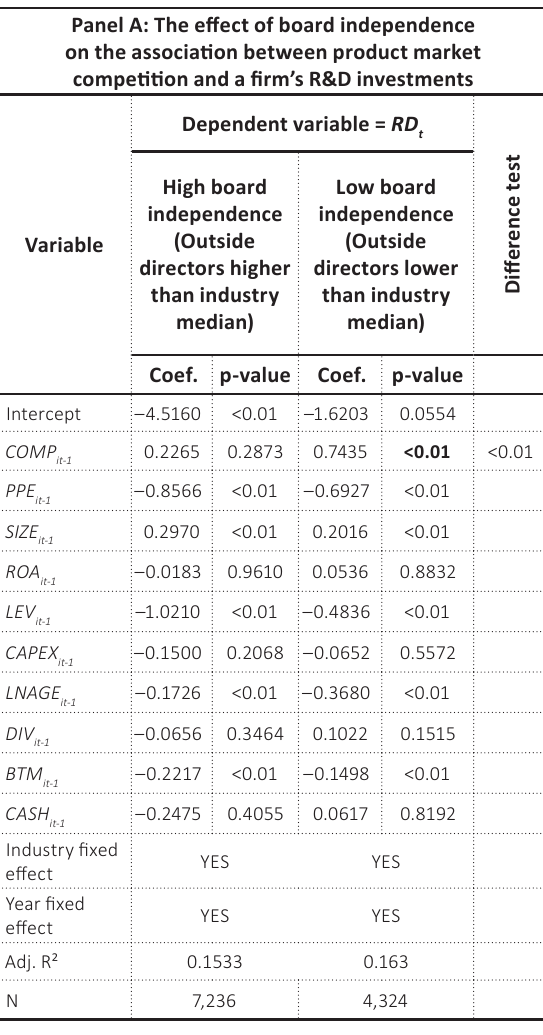
Table 4. The effect of internal